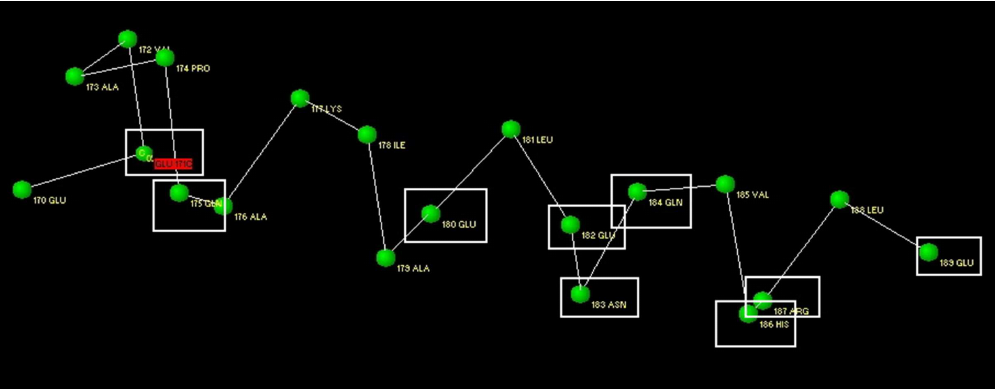
Figure 5. Fragment of PSP protein, forming a CIHBS link with N-lobe of LF.